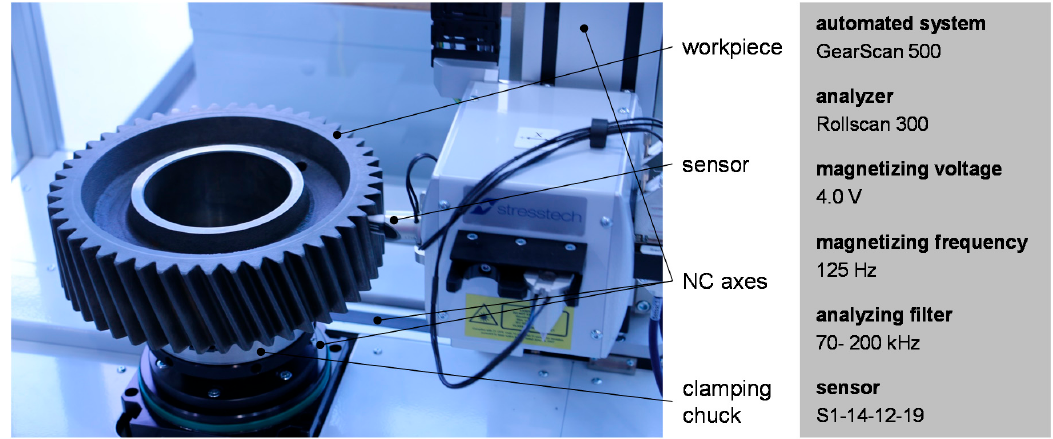
Figure 6. GearScan 500 in use and measurement parameters.